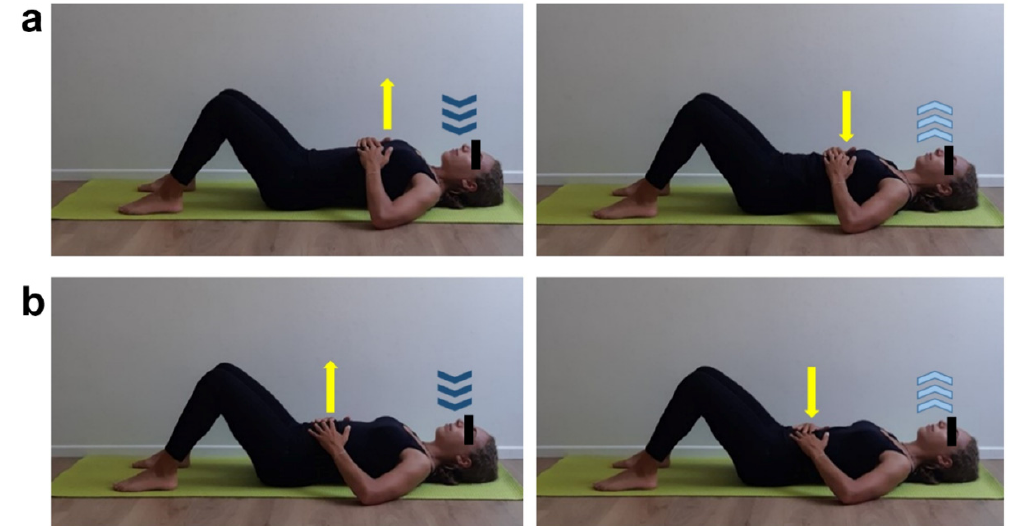
Figure 2. Breathing exercises. ( a ) Supine position, flexed legs. Focus on costal breathing by placing open hands on last ribs and perceiving chest expansion / retraction (yellow arrows). Inhale (dark blue arrows) through the nose, direct the breath to the center of chest and exhale (light blue arrows) through the mouth. Five min work. ( b ) Supine position, flexed legs. Focus on diaphragmatic breathing by placing open hands on abdomen. Inhale (dark blue arrows) through the nose and perceive abdomen lifting upward (yellow arrow), direct the breath to lower chest area and exhale (light blue arrows) through the mouth perceiving abdomen getting downward (yellow arrow). Five min work.